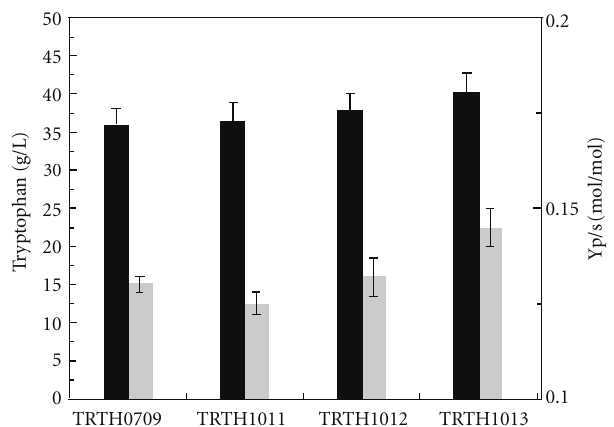
Figure 4: L-tryptophan accumulation (black bars) and substrate- specific product yields (Yp/s) in mol L-tryptophan per mole glucose (grey bars) at the end of the production phases of representative fed-batch fermentations. Means are from at least three independent experiments. Table 3: Stability of plasmids pSV709 and pMEL03 in TRTH1013 after 40h of fermentation. Stability with Stability without Plasmids tetracycline and antibiotics (%) chloramphenicol (%) pSV709 100 ± 2 . 3 98 ± 2 . 5 pMEL03 85 ± 7 . 1 86 ± 4 . 4 pSV709 and pMEL03 84 ± 6 . 2 83 ± 4 . 5 Values show the ratio in percentage of colonies on agar plates with antibi- otics to colonies on agar plates without antibiotics. Means are determined from at least three independent